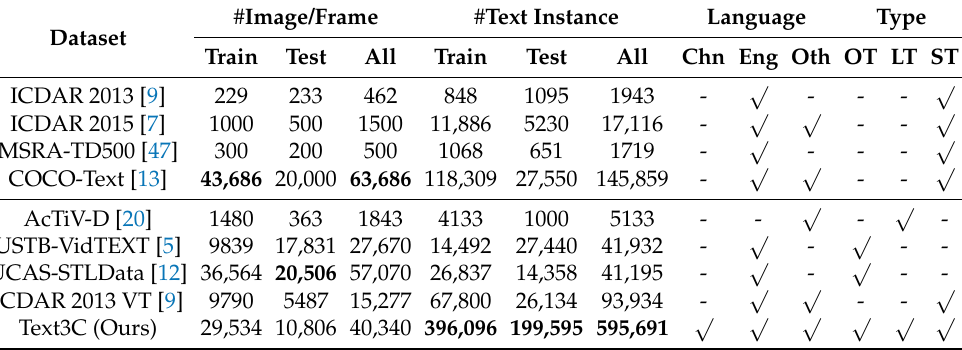
Figure 3. Statistical comparison of the established Text3C dataset. The dataset includes 13 training videos ( a ) and 7 test videos ( b ), and each video contains a different number of video frames. The examples of text types ( c ) and languages ( d ) show similar statistical distributions in the training and test sets. Table 1. The statistical comparison of the Text3C dataset and current mainstream datasets. We use to indicate available features and - for unavailable features. For the language attribute, we use Chn, Eng, and Oth to denote Chinese, English, and Other languages, respectively. Notably, the dataset AcTiV-D contains Arabic language videos, which we group as Other . For the type attribute, we use OT, LT, and ST to indicate overlaid text, layered text, and scene text, respectively. Bold indicates the largest